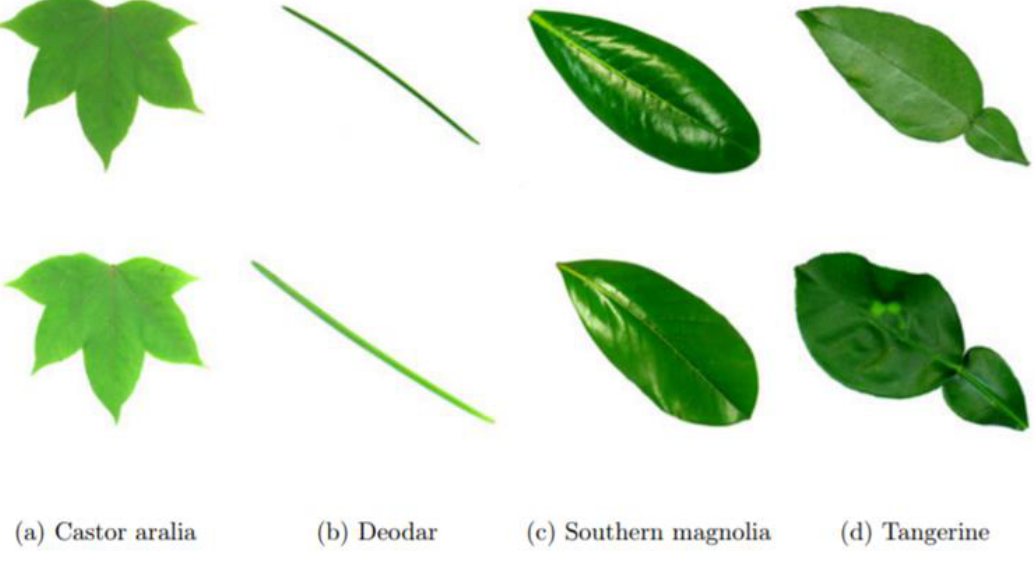
Figure 14. Samples from the Flavia leaf dataset.